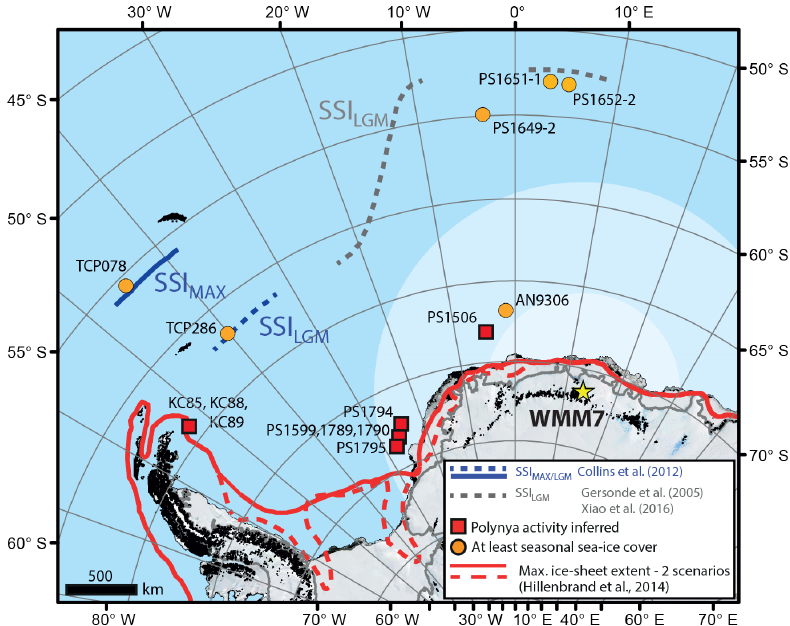
Figure 1. Sea-ice records of the last glacial stage for the Atlantic sector of the Southern Ocean. The stomach-oil deposit presented here (WMM7) is shown by the yellow star (Untersee Oasis; 71 ◦ 22 (cid:48) S, 13 ◦ 19 (cid:48) E). The likely snow petrel foraging range is indicated by the shaded ellipse: although snow petrels can forage 2600 ± 1000km from their nests (pale shading) they are found in their highest densities within 700km of the nest site during the breeding season (darker shading) (Delord et al., 2016). Boundaries of the maximum summer sea-ice extent (22–30ka; Allen et al., 2011; Collins et al., 2012) and LGM summer sea-ice extent (19–23ka; Gersonde et al., 2005; Xiao et al., 2016) are marked. Sites where polynya activity has been inferred for the last glacial stage are shown in red (Bonn et al., 1998; Smith et al., 2010; Sprenk et al., 2014; Weber et al., 1994), noting that the KC sites (Smith et al., 2010) and south-eastern Weddell Sea sites (PS1599, 1789, 1790, and 1974; Weber et al., 1994; and PS1795; Sprenk et al., 2014) infer polynyas opening “upstream” of the core locations. Note that the continental shelf edge is effectively also delineated by the solid red line of LGM maximum ice-sheet